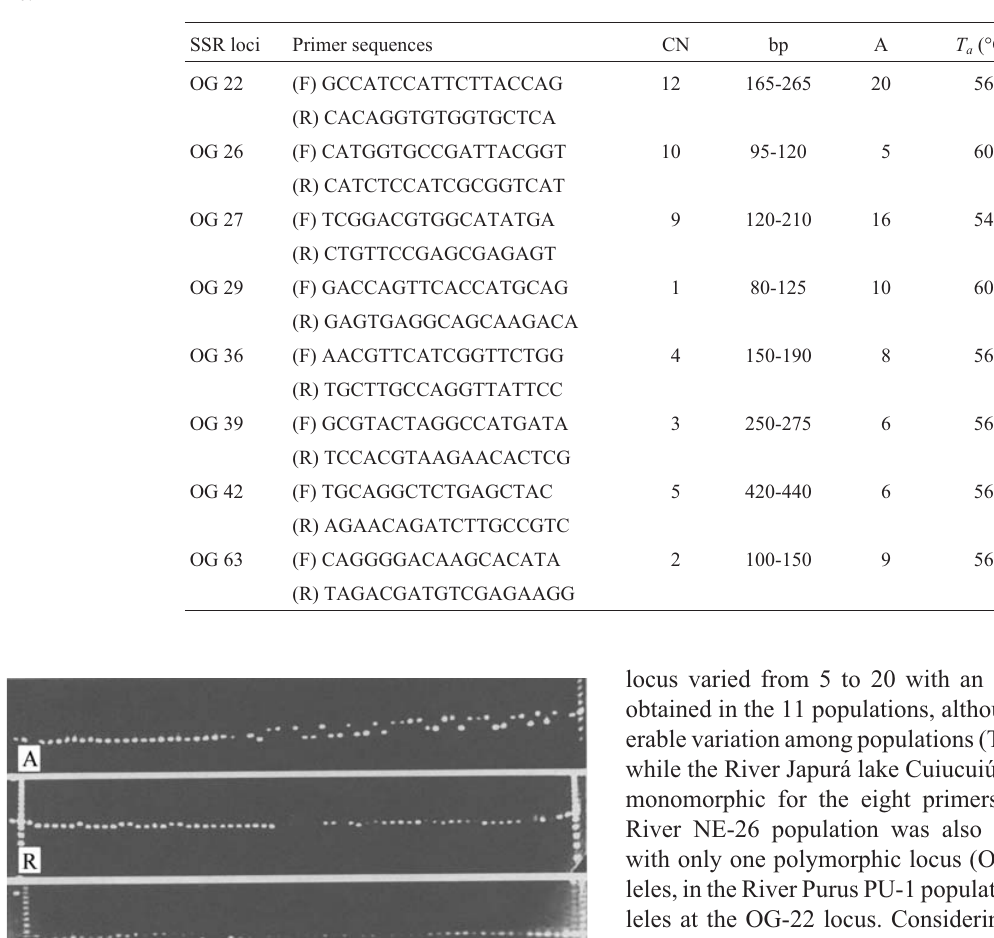
Table 2 - Simple sequence repeat (SSR) loci, primer-pair sequences developed for Oryza glumaepatula (Brondani et al. 2001), chromosome number (CN), allele size range in base pairs (bp), number of alleles per locus (A) and annealing temperatures ( T a ). The mean number of alleles per locus (A) was 10.